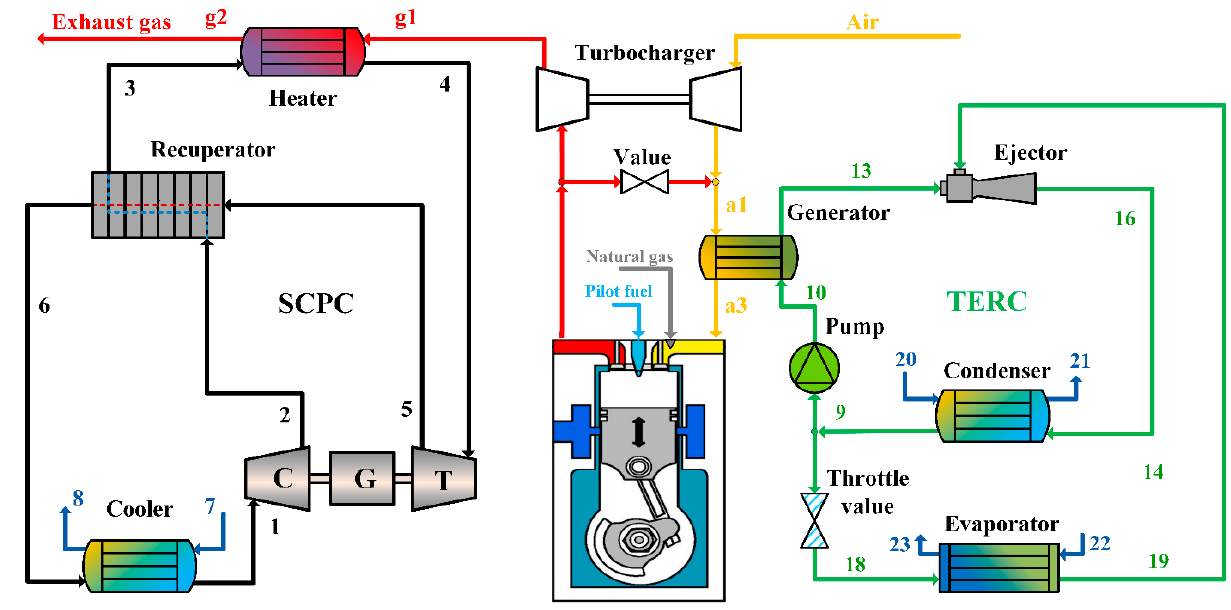
Figure 2. This schematic diagram of the proposed WHR system for marine dual fuel engine.